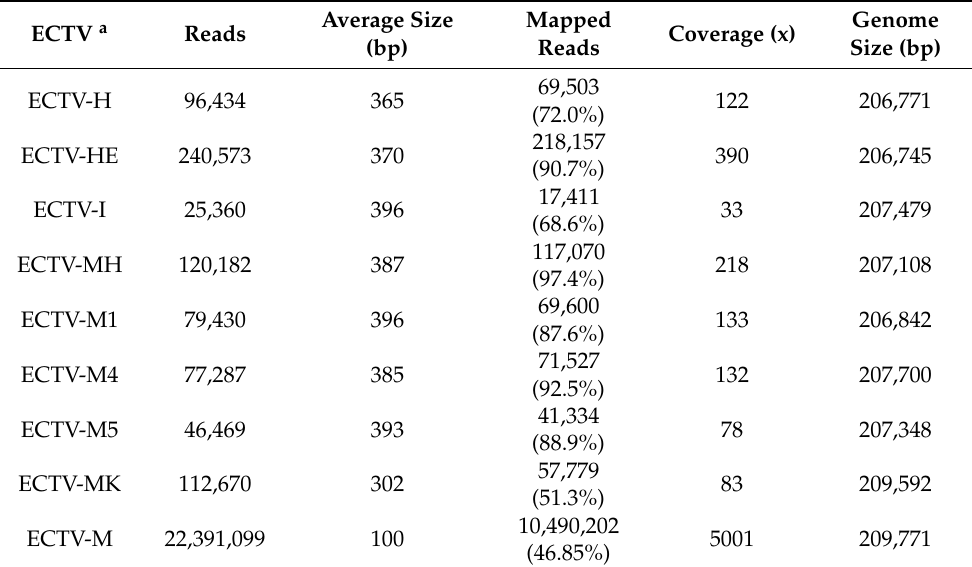
Table 2. Summary of data obtained by next-generation sequencing of the ECTV